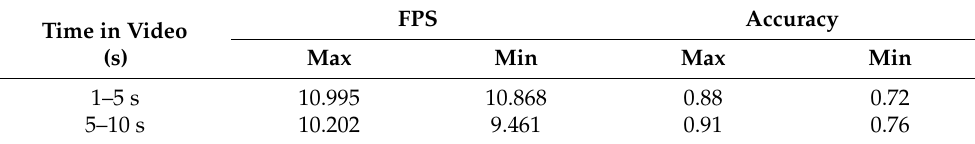
Table 10. The evaluation results of videos of the car detection model. Time in